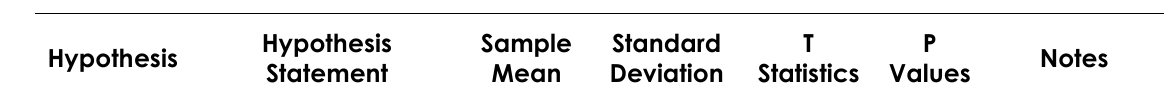
Hypothesis Result